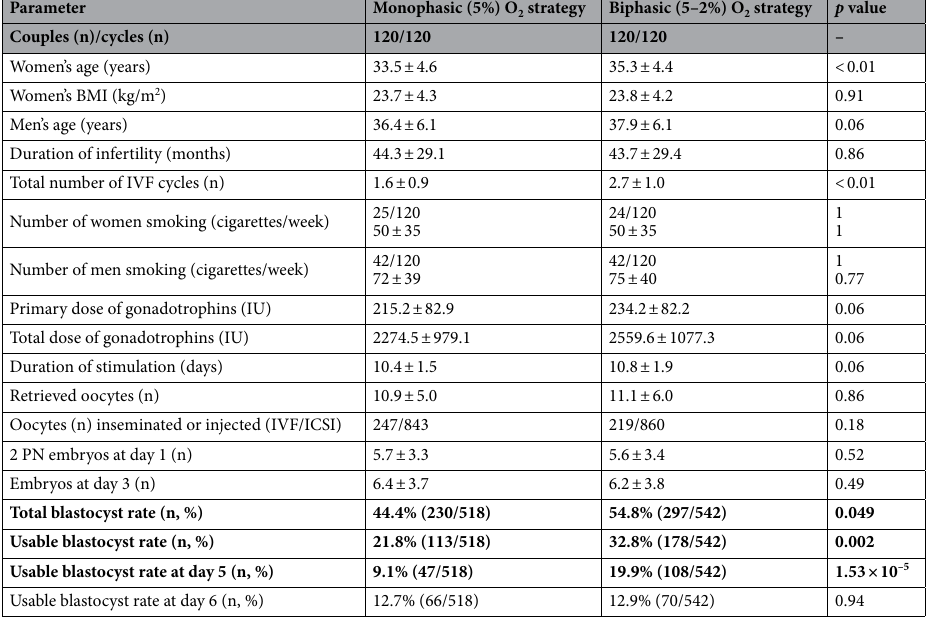
Table 1. Characteristics of the couples and biological parameters of the IVF cycles used for the primary objective. Data are reported as means and standard deviations (SD). BMI body mass index, IVF in vitro fertilization, IU International Unit, PN pronuclei. Data in bold indicate statistically significant results.